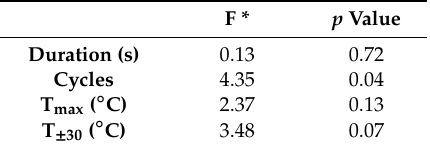
Table 3. Comparison of variances in the two experimental groups.